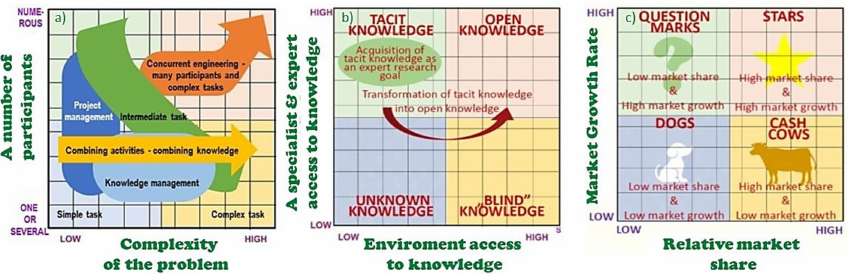
Figure 2. Contextual matrices schemas: ( a ) dependence of the complexity of the problem being solved on the number of participants in concurrent engineering; ( b ) the availability of knowledge; ( c ) BCG for market assessment.